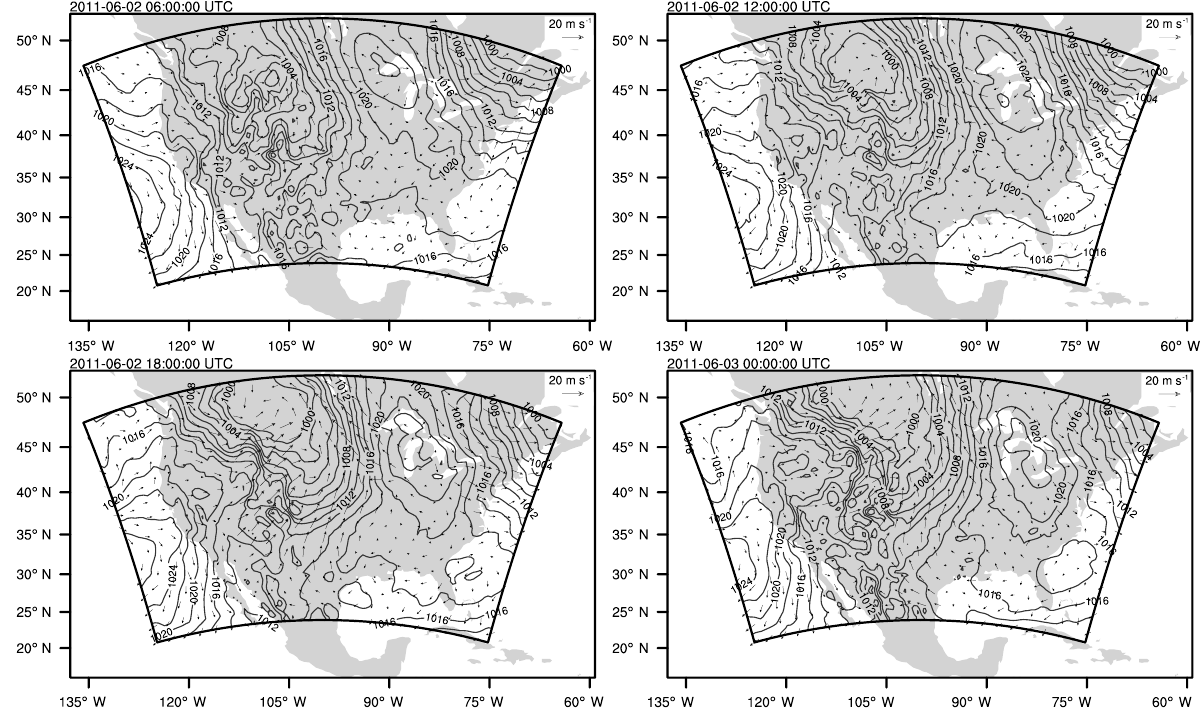
Figure 5. Sea level pressure (hPa) and horizontal wind (ms − 1 ) at the model’s lowest vertical level plotted at 6h intervals during the 24h simulation starting on 2 June 2011 at